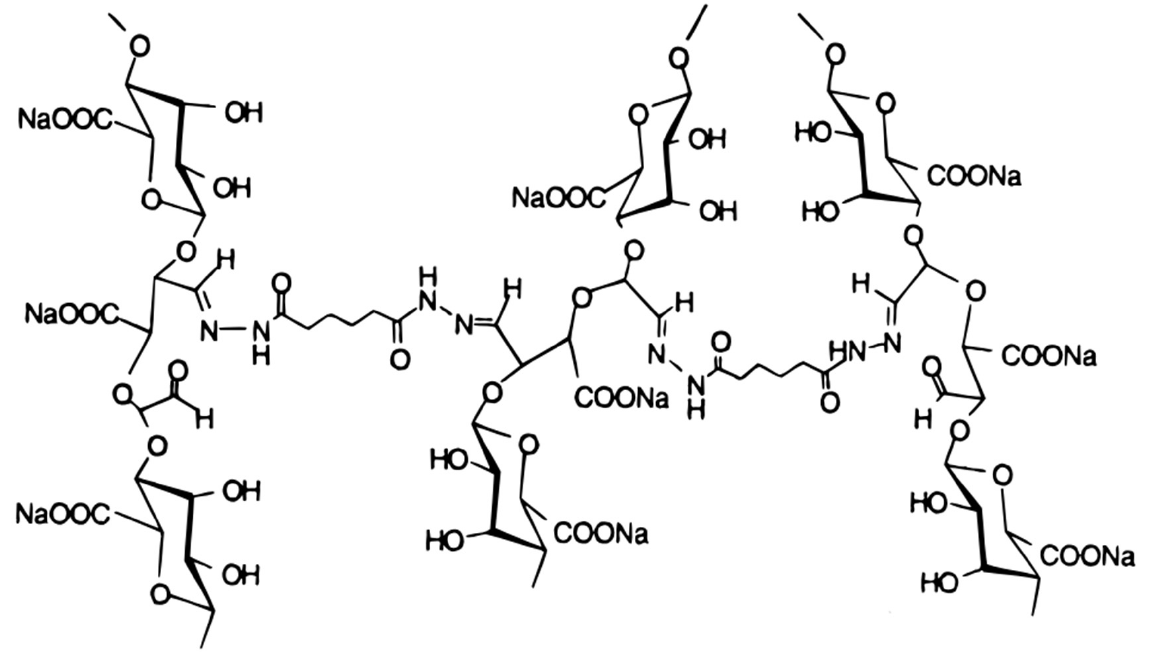
Figure 6. Poly(aldehyde guluronate) gels covalently cross-linked with adipic acid dihydrazide. Reprinted with permission from [308]. Copyright 2013 American Chemical Society.